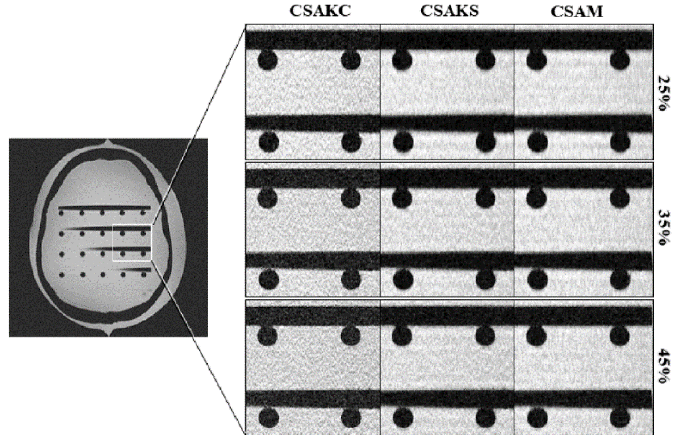
Figure 3. CSAM, CSAKS, and CSAKC images at different undersampling ratios in the brain phantom. Unlike CSAKC, linear and blurring artifacts can be seen with CSAM and CSAKS. Artifacts are most severe in the CSAM image.